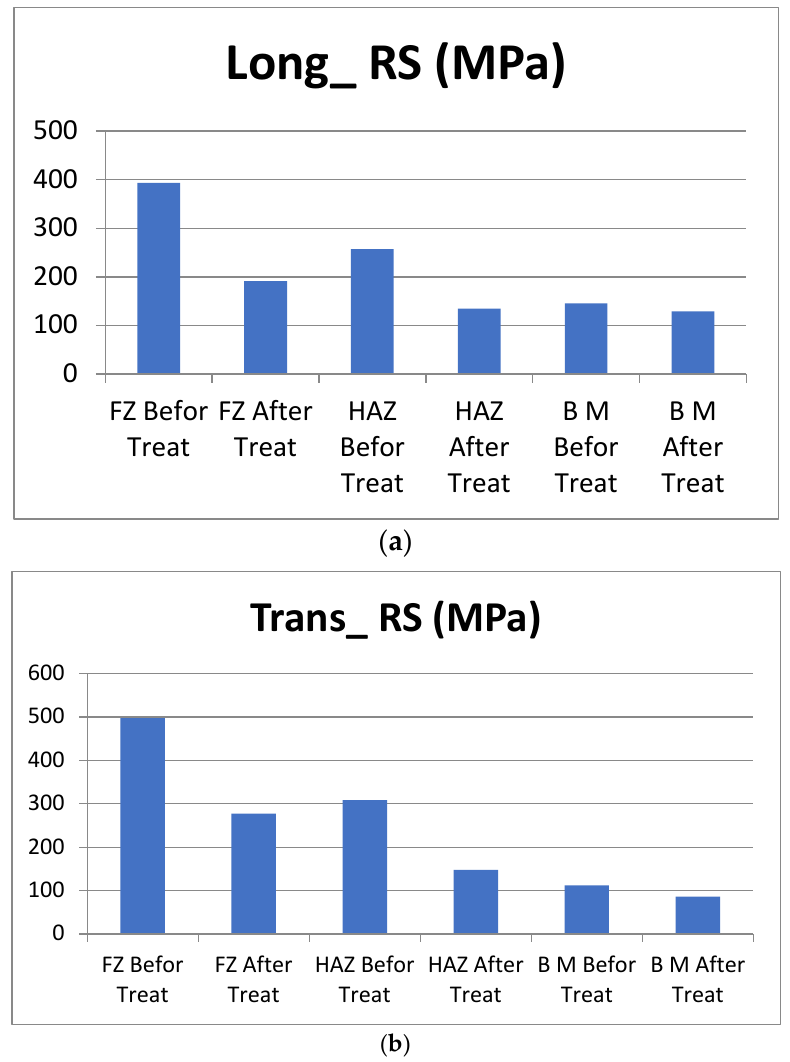
Figure 20. ( a ) Average values of longitudinal residual stresses before and after treatment. ( b ) Average values of transversal residual stresses before and after treatment.